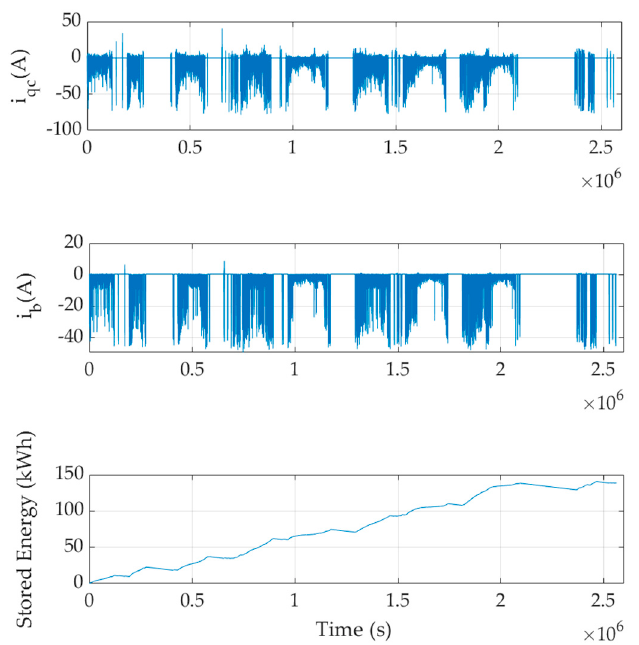
Figure 15. Energy storage module behaviors in March.